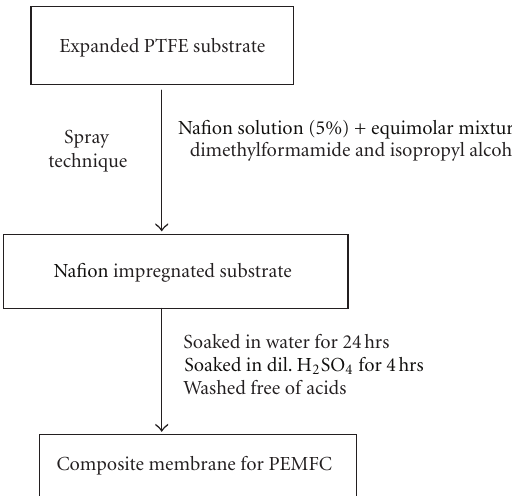
Figure 1: Fabrication procedure for composite